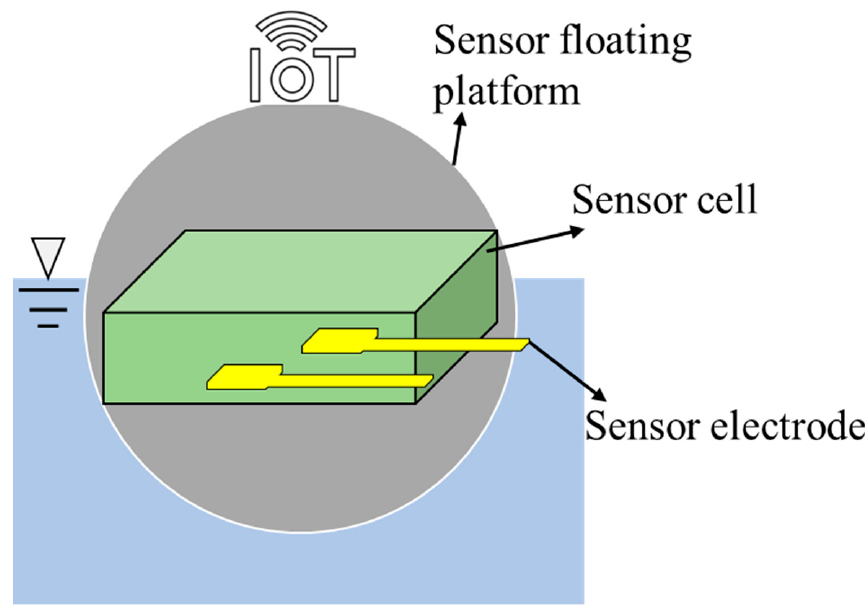
Figure 2. Schematic diagram of the typical sensor for water quality analysis. Three-dimensional printing can be employed to fabricate the sensor’s supporting platform, cell and/or electrode.